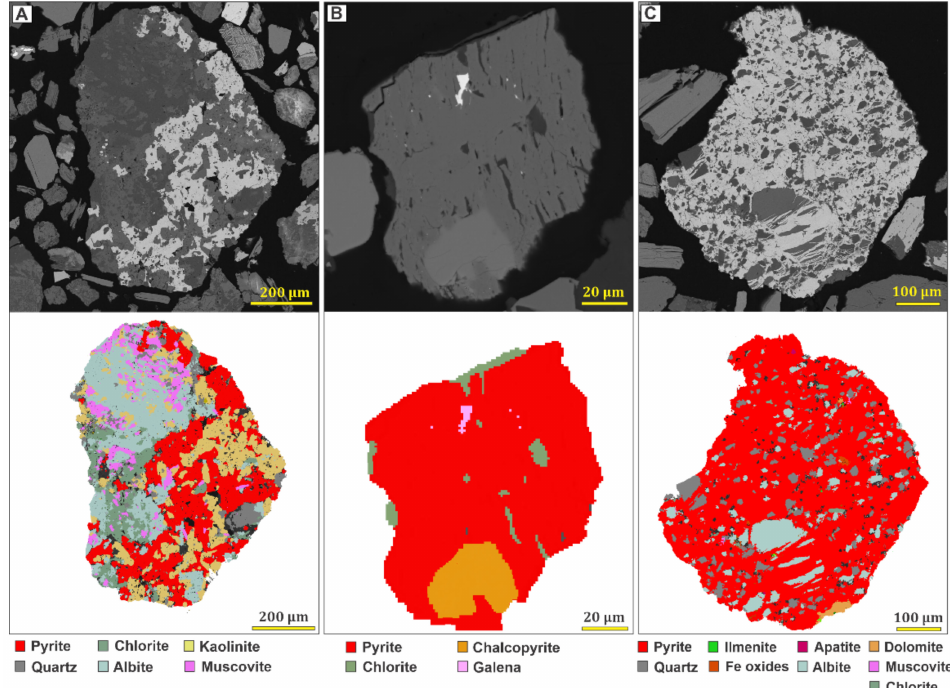
Figure 13. BSE images and the corresponding TIMA mineral maps of detrital sulfides ( A , B ) and diagenetic pyrite ( C ) at the base of the Permian cover. ( A ) Detrital pyrite is associated with a hydrothermal mineral assemblage including quartz, albite, microcline, chlorite, calcite, muscovite, kaolinite, gypsum, rutile, and titanite. ( B ) Detrital pyrite contains inclusions of chalcopyrite, galena, and chlorite. ( C ) Diagenetic pyrite and dolomite cementing quartz, albite, chlorite, muscovite, ilmenite, kaolinite, apatite, and Fe